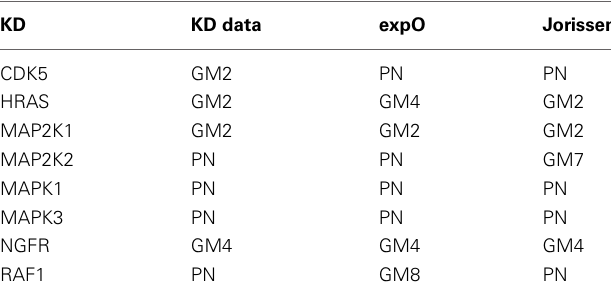
Table 3 | Best single prior source across three large colorectal cancer data sets (kd for knock-down experiments in colorectal cancer cell lines, expO and jorissen for large human colon tumor data) when combined with microarray gene expression data (prior weight w = 0 .